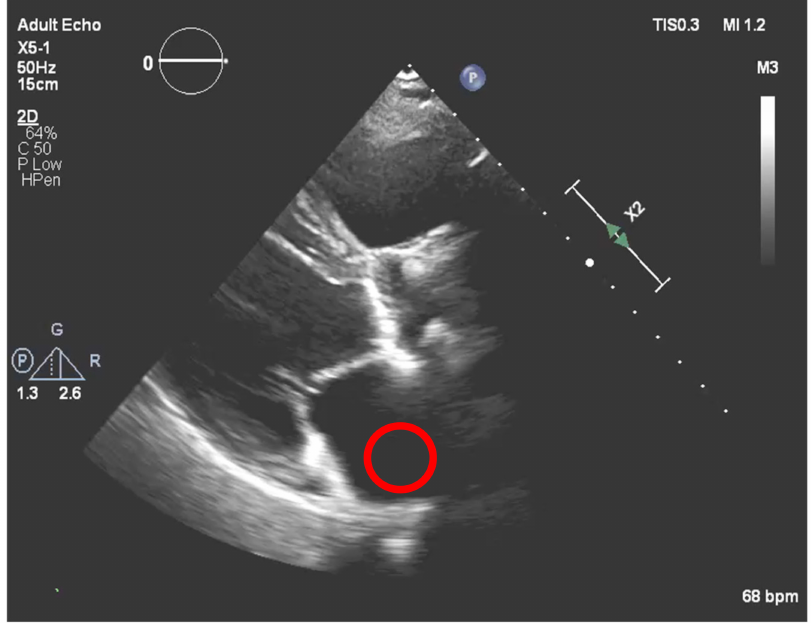
Figure 17. Left atrium cavity region that will create a dynamic threshold for binarization.